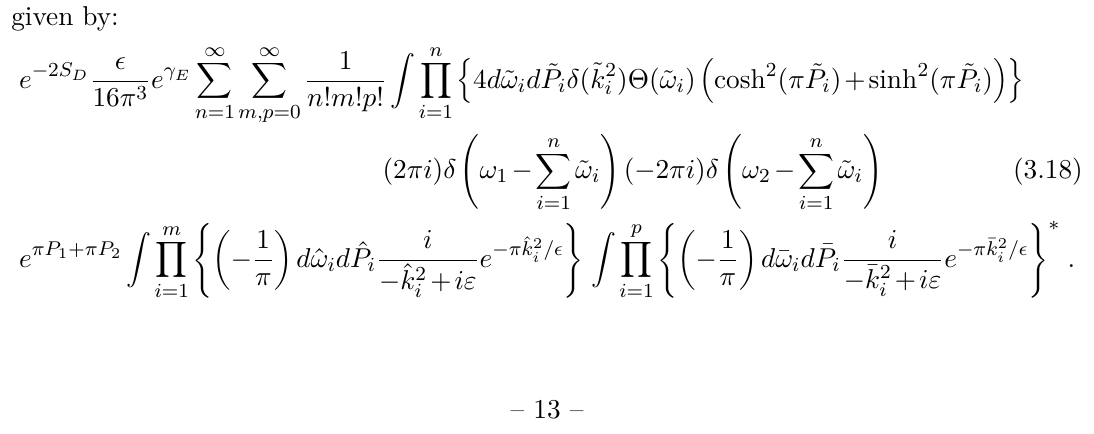
M 1 . The thin vertical lines represent 1